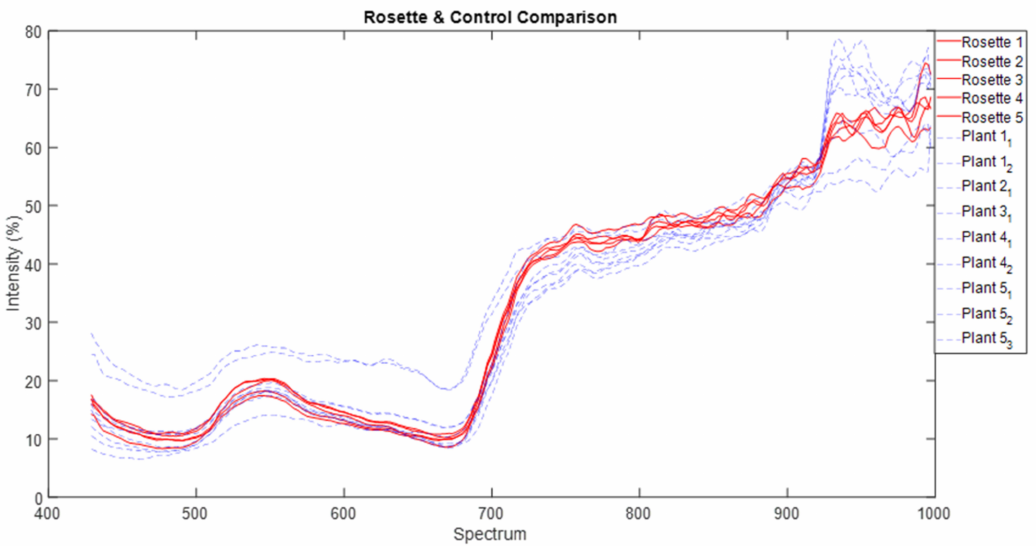
Figure 15. Spectral signature of the rosette stage of parthenium weed compared to the non- parthenium/control plants (Plant 1–Plant 5).